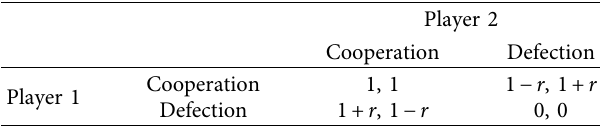
Table 3: SDG reward